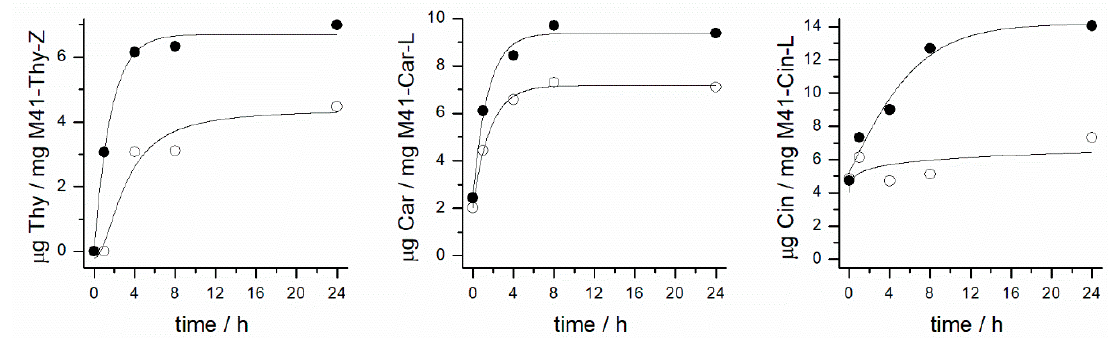
Figure 6. Cargo release profiles of EOCs from M41–Thy–Z (left); M41–Car–Z (center) and M41–Cin–Z (right) in H 2 O at pH 8. ( ⚪ ) in the absence and ( ● ) in the presence of proteolytic enzymes (pronase).